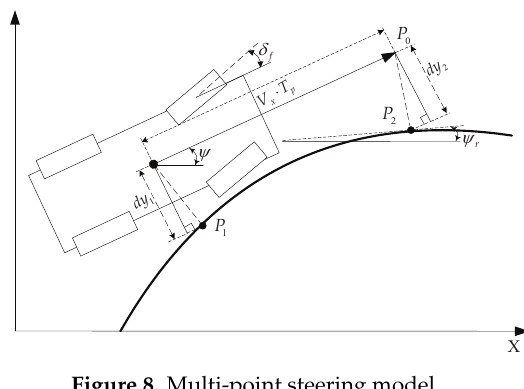
Figure 8. Multi-point steering